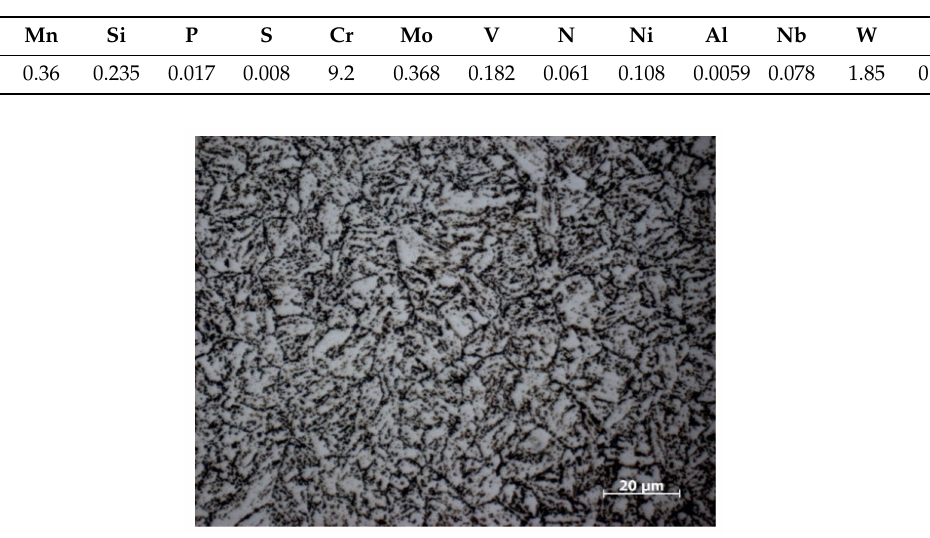
Table 1. Chemical compositions of P92 steel (wt. %).